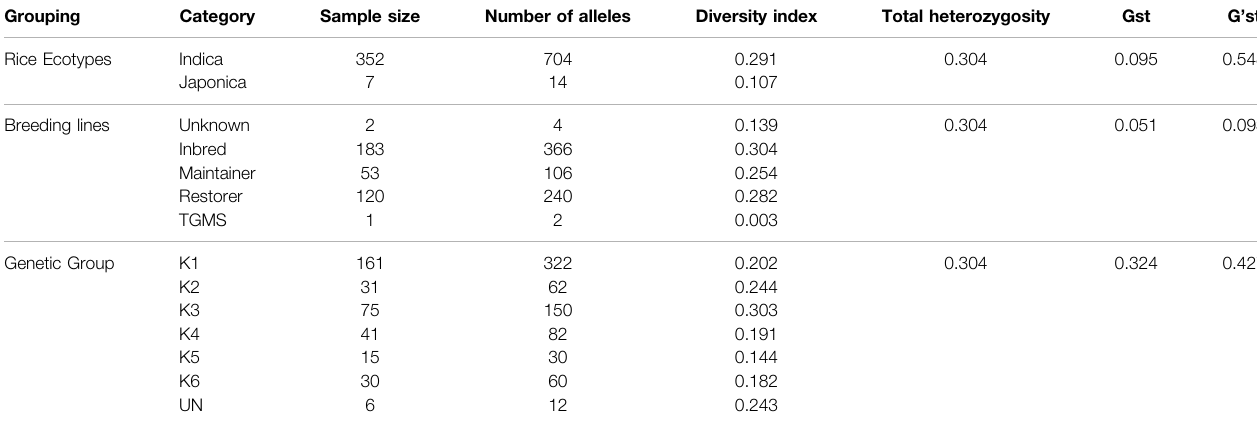
TABLE 1 | Amount of diversity index, heterozygosity, divergence, and number of alleles in ecotypes, breeding lines, locations, and genetic groups. Grouping Category Sample size Number of alleles Diversity index Total heterozygosity Gst G ’ st Rice Ecotypes Indica